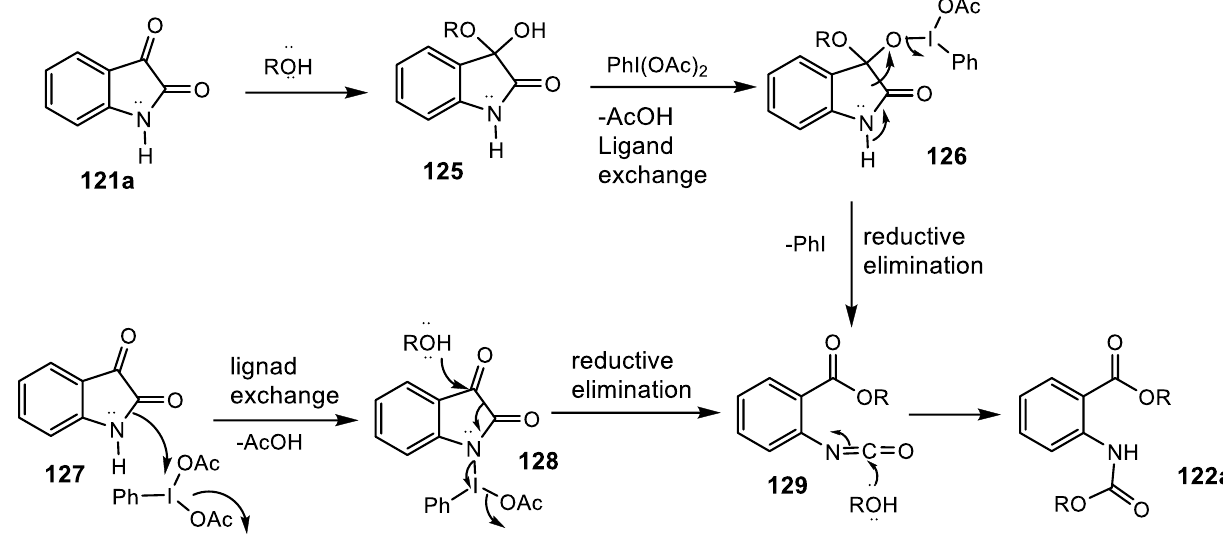
Figure 17. Plausible mechanism for the oxidative cleavage of C2 – C3